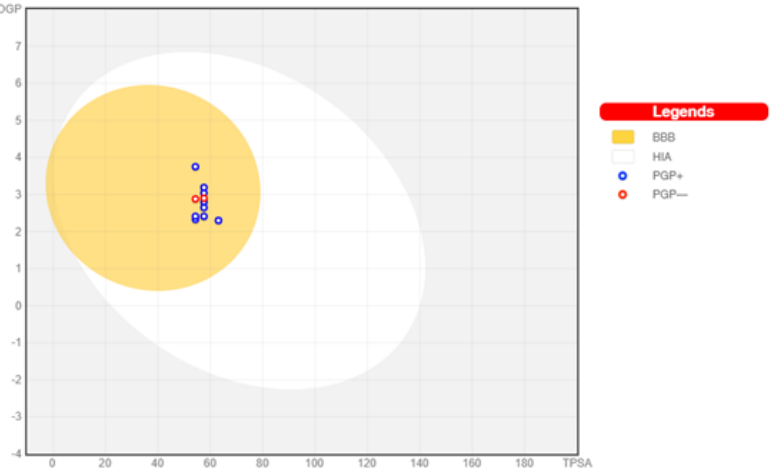
Figure 3. Graph of the dependence of lipophilicity on the polarity of the studied molecules 1 – 11 , determined by the BOILED-Egg method [21].